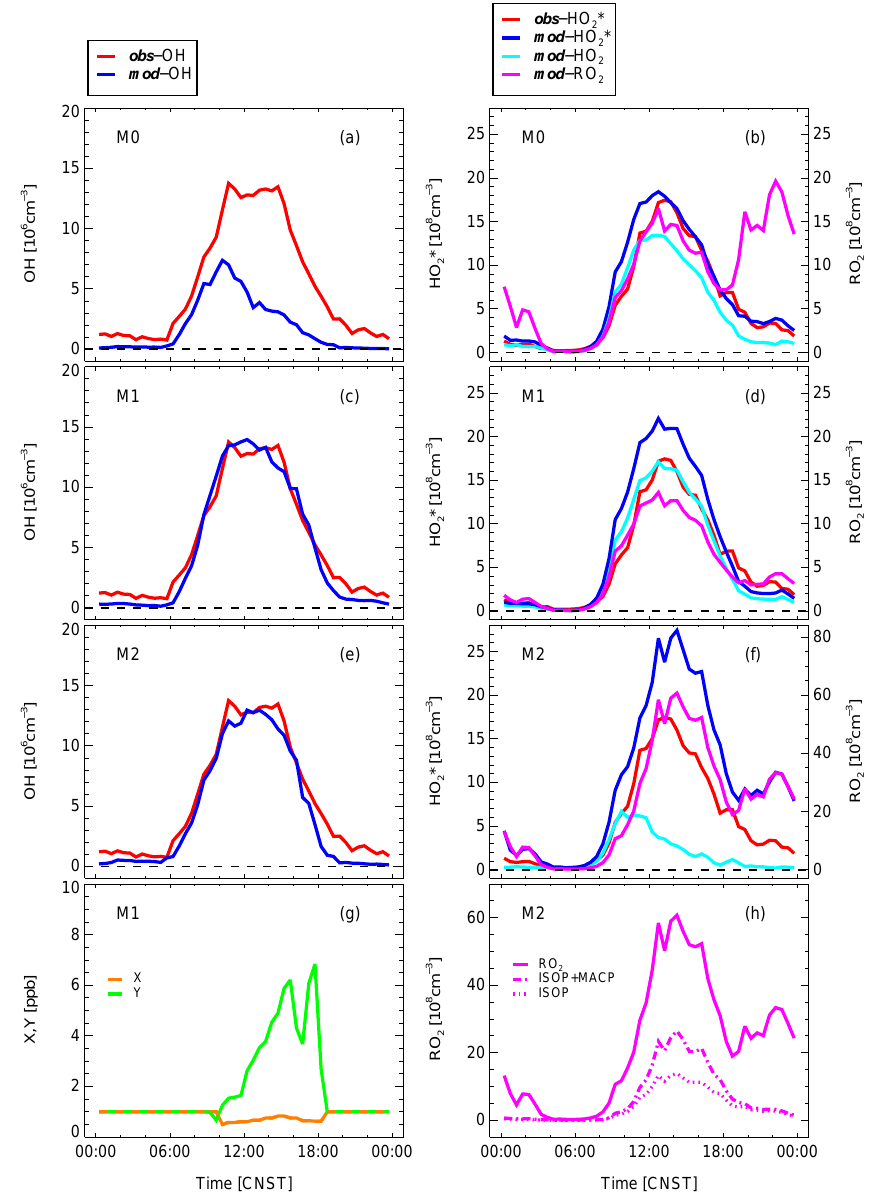
Fig. 11. Comparison of measured and modelled concentrations of OH and HO ∗ 2 for three mechanistic scenarios (M0, M1 and M2). Panels (b) , (d) and (f) show the modelled values of HO 2 and RO 2 as well. The fitted concentrations of the generic species X (scenario M1) and Y (scenario M2) are presented as NO equivalents in panel (g) , and model results for peroxy radicals (ISOP, ISOP+MACP, total RO 2 ) in panel (h) .